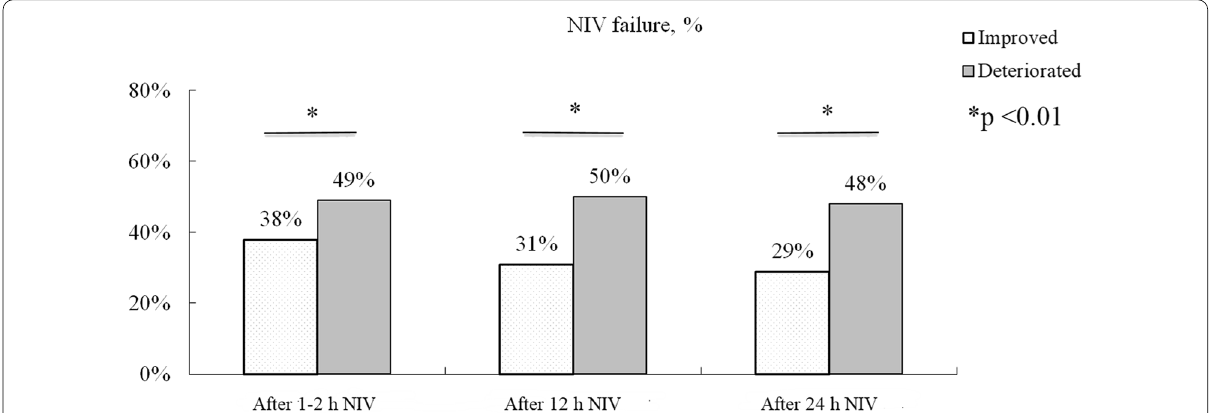
Fig. 5 Rates of NIV failure in patients whose ROX index improved or deteriorated relative to values collected before NIV. ROX SpO 2 /FiO 2 to respiratory rate, NIV noninvasive